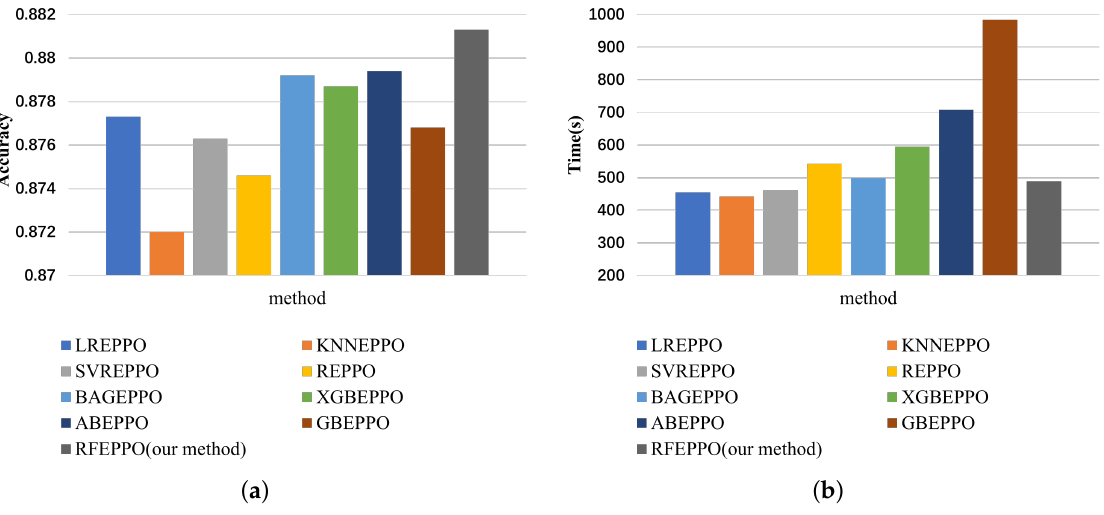
Figure 9. The performance of PPO with different surrogate models on Turkiye Student Evaluation data set: ( a ) the average accuracy; ( b ) the average time.